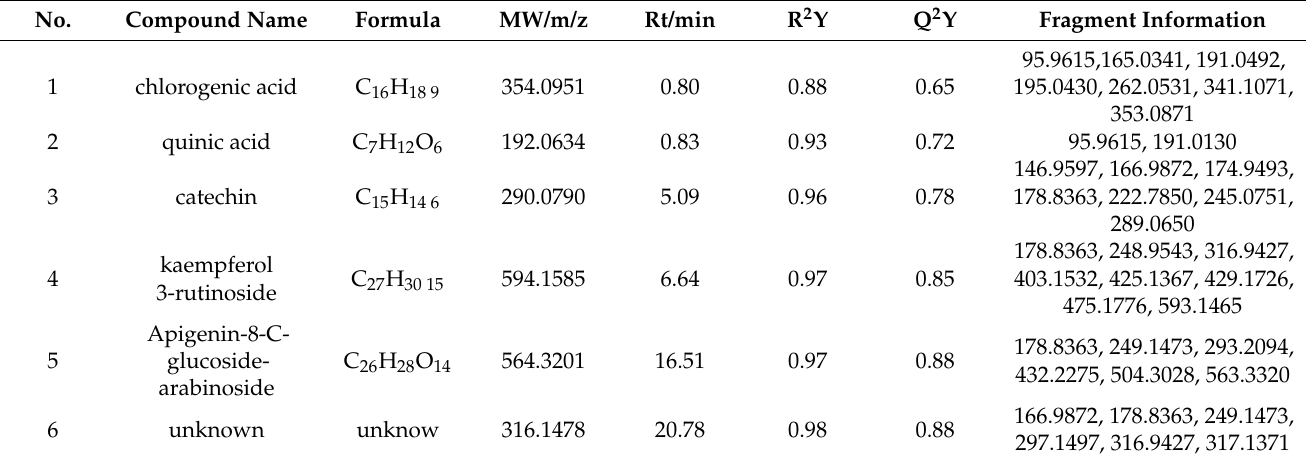
Table 2. Identification of chemical components of T. hemsleyanum metabolites associated with HepG2 hepatocellular carcinoma cells.